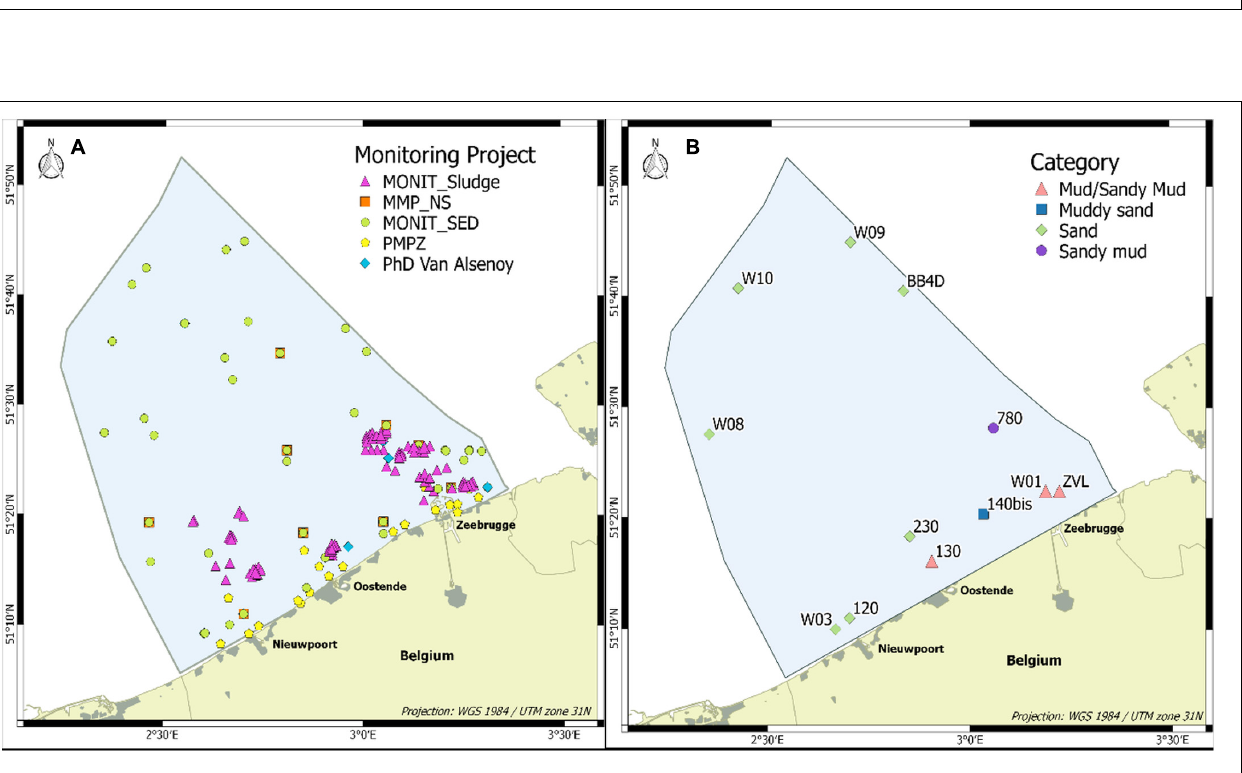
FIGURE 1 | Flow chart of the data process procedures including (1) development of normalization approaches (left), compilation of quality checked datasets (center) and trend modeling (right). Actions are given in uncoloured textboxes. Samples, datasets and results are presented in orange textboxes.